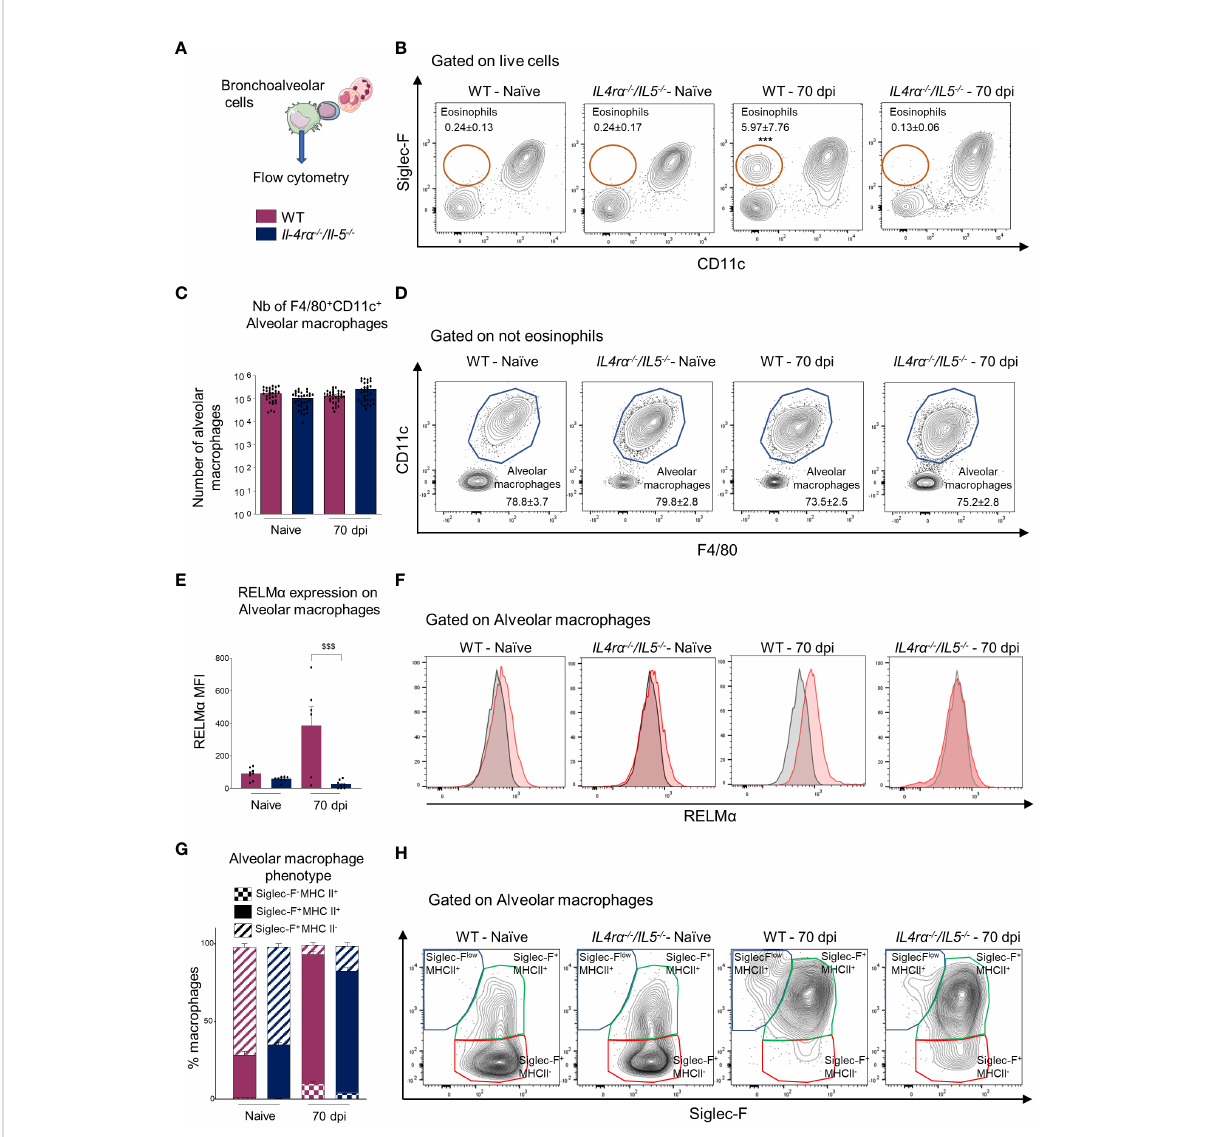
FIGURE 5 Monocyte-derived macrophages replenish the alveolar niche. Bronchoalveolar cells were isolated from naive or L. sigmodontis infected WT and Il-4r a -/- /Il-5 -/- BALB/c mice at 70 dpi. CD11c + F4/80 + alveolar macrophages were analyzed by fl ow cytometry. (A) Experimental setup. (B) Representative plots and gating strategy for Siglec-F + eosinophils. Average frequency +/- SEM of the different population is displayed. (C) Absolute number of CD11c + F4/80 + alveolar macrophages. (D) Representative plots and gating strategy for CD11c + F4/80 + alveolar macrophages. Average frequency +/- SEM of the different population is displayed. (E) Mean fl uorescence intensity (MFI) of RELM a expression on CD11c + F4/80 + alveolar macrophages. RELM a expression was normalized by subtracting the Fluorescence Minus One (FMO) control MFI. (F) Representative expression of RELM a by CD11c + F4/80 + alveolar macrophages. Shaded histograms represent FMO controls. (G) Average frequency of Siglec-F low MHC + , Siglec-F + MHC + and Siglec-F + MHC - cells among CD11c + F4/80 + alveolar macrophages. (H) Representative plots and gating strategy for Siglec-F low MHC + , Siglec-F + MHC + and Siglec-F + MHC - cells among CD11c + F4/80 + alveolar macrophages. Dots represent individual mice and results are expressed as mean ± SEM. (C) n=30-34 naive and n=20 infected mice per group, pool of 6 independent experiments. (E) n=6-8 mice per group, pool of 2 independent experiments. (G) n=10-16 mice per group, pool of 3 independent experiments. Two-way ANOVA: $$$ p<0.001 represent differences between mice